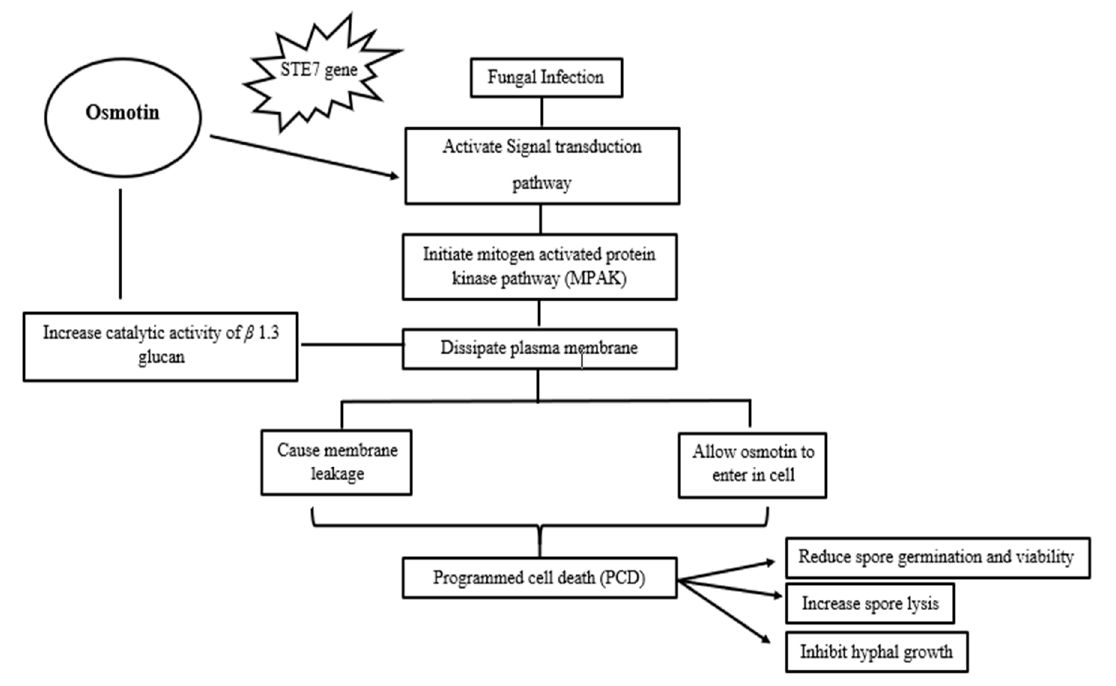
Schematic diagram representing the osmotin mechanism in inducing tolerance to fungal infections.